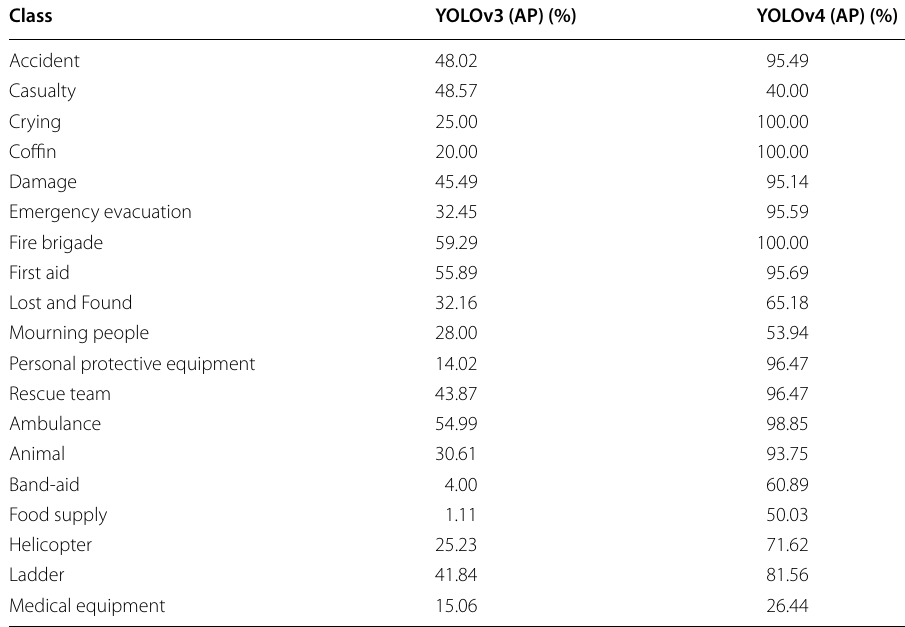
Table 8 AP of YOLOv4 and YOLOv3 on the custom dataset Class